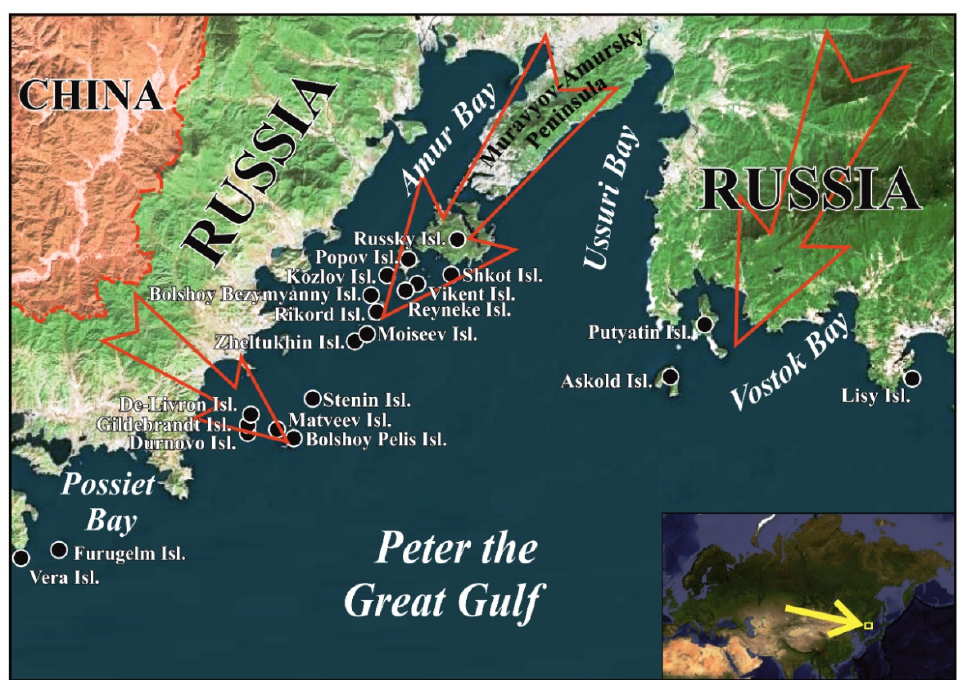
Figure 1. Collection and observation points of Scarabaeoidea on the islands of the Peter the Great Gulf. The islands flora is related to the nearby mainland, the East Asian